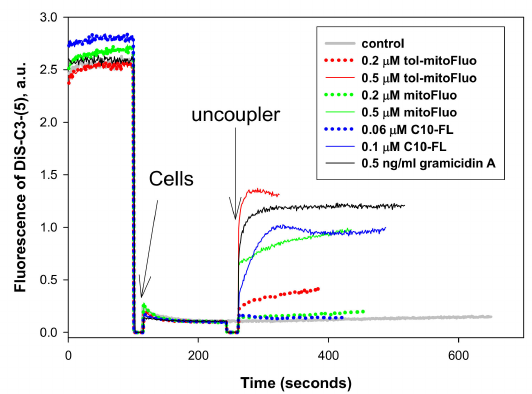
Figure 4. The e ff ect of tol-mitoFluo, mitoFluo, and C10-FL on the membrane potential in B. subtilis . Changes in the membrane potential were monitored by measuring the fluorescence of DiS-C3-(5) (10 µ M) in PBS bu ff er. Gramicidin A concentration, 0.5 ng / mL.